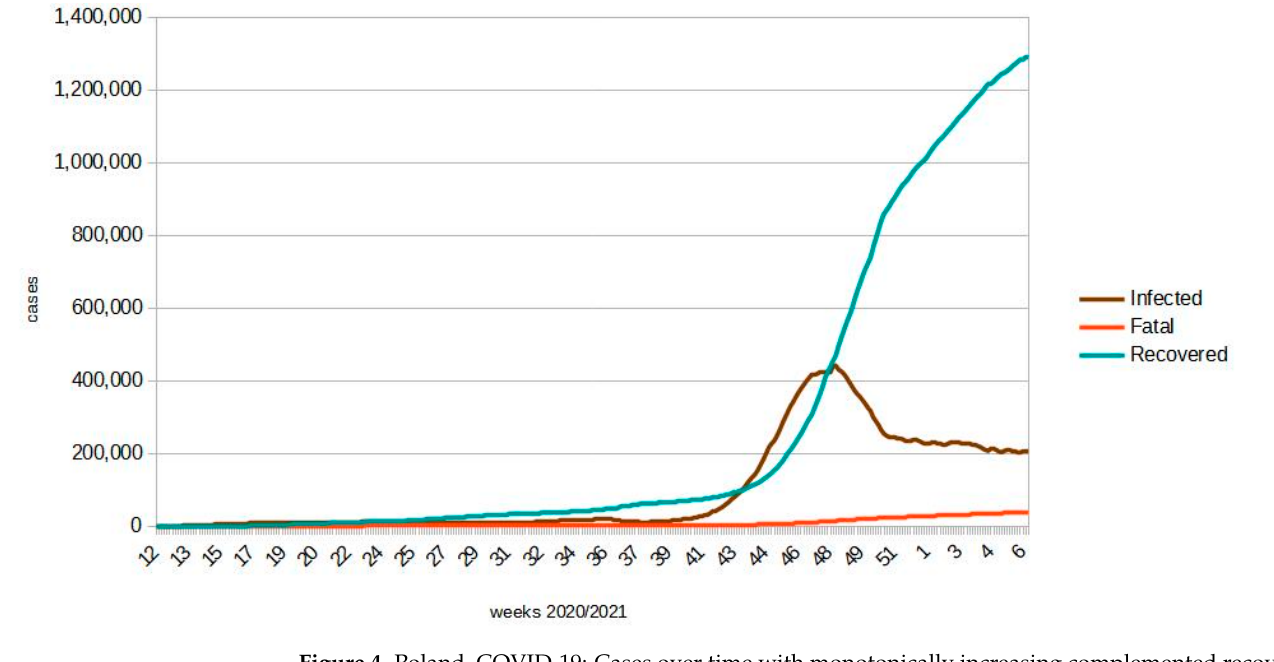
Figure 4. Poland, COVID-19: Cases over time with monotonically increasing complemented recovered data (as of 7 February 2021; results: CovsirPhy Python Application).